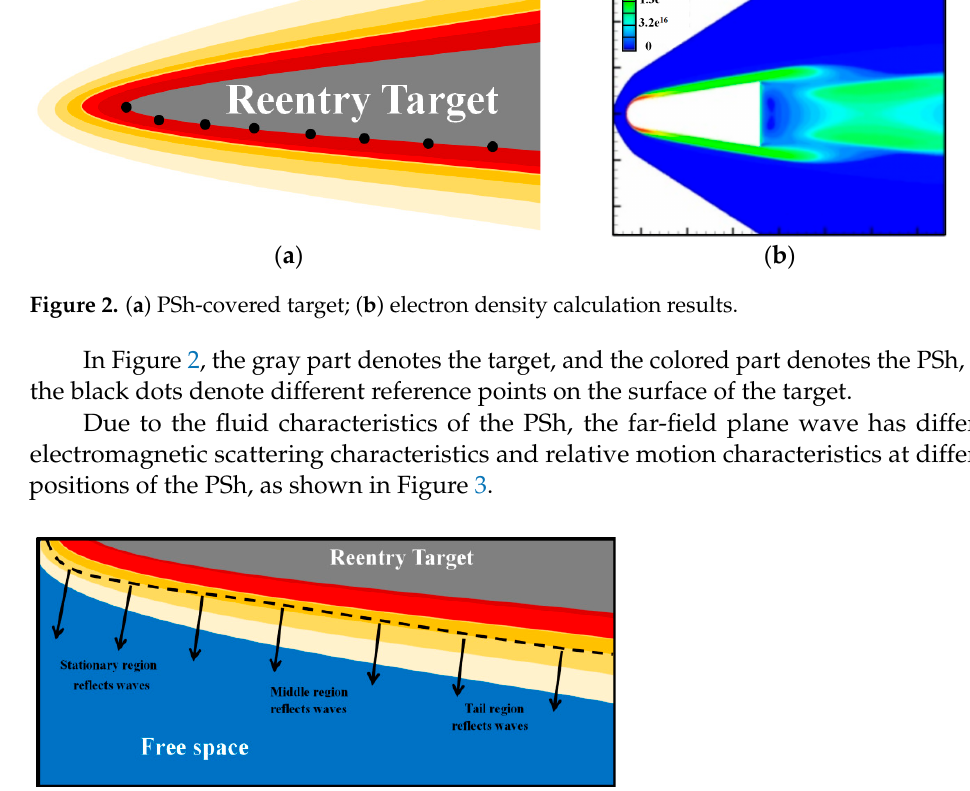
Figure 3. Local reflection characteristics of PSh-covered targets.